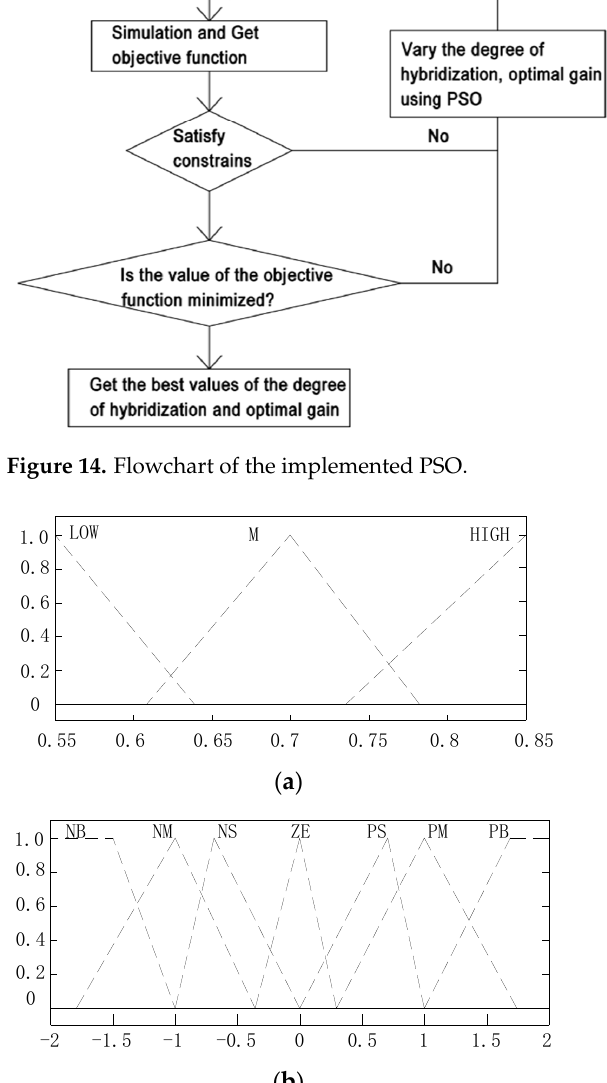
Figure 15. Optimization results of the membership function: ( a ) adjusted MFs of SOCuc and SOCbat and ( b ) adjusted MFs of PREF-bat.